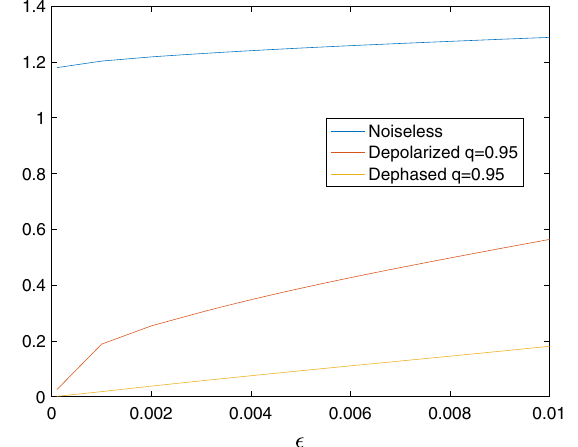
FIG. 11. Plot of ε -hypothesis-testing upper bound on the conference key rate for two copies of the Φ W 3 state, for noiseless, dephased, and depolarized